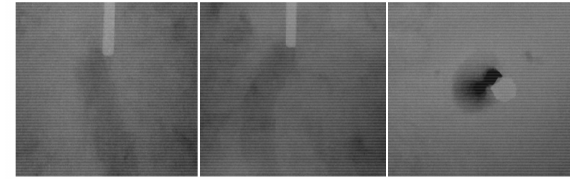
Figure 3. Three views of discharge